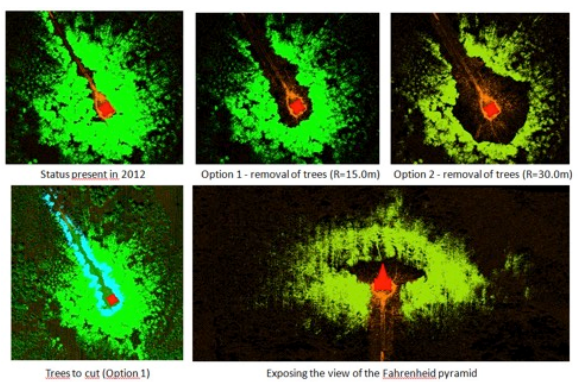
Figure 12. Options showing all vegetation threatening the safety of the Pyramid removed as well as removing all obstructions to make the building visible (Created by K. Zi ę ba).